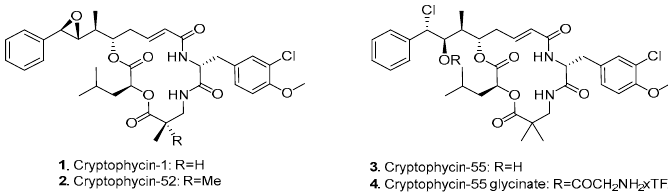
Figure 1. Chemical structure of cryptophycin derivatives.